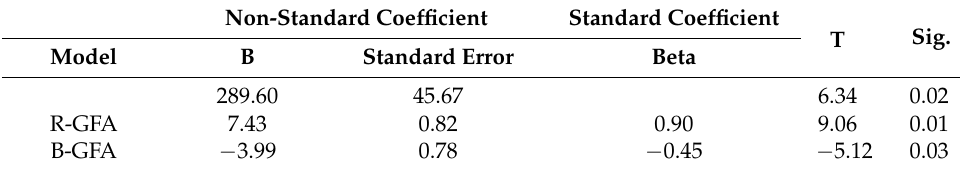
Table 12. Corresponding coefficients.